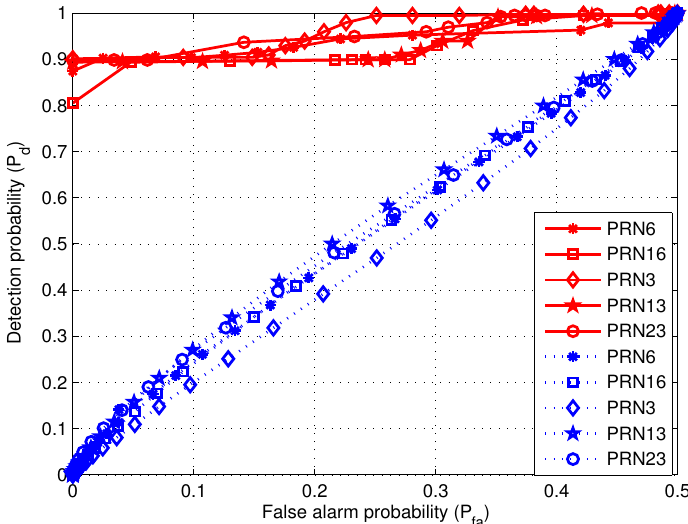
Figure 10. The relationship between detection probability and false alarm probability for the first 200 s data. The red solid and blue dashed curves are separately corresponding to the proposed algorithm and the ratio